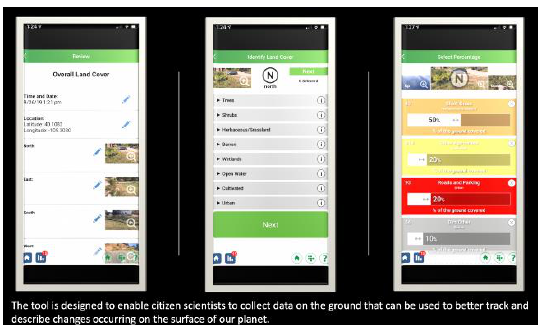
Figure 4. Screenshots of the GLOBE Observer Landcover tool. Left: voucher photographs of landcover for each cardinal direction. Middle: landcover elements available for selection by app user. Right: Slides enable user to estimate landcover in 10%